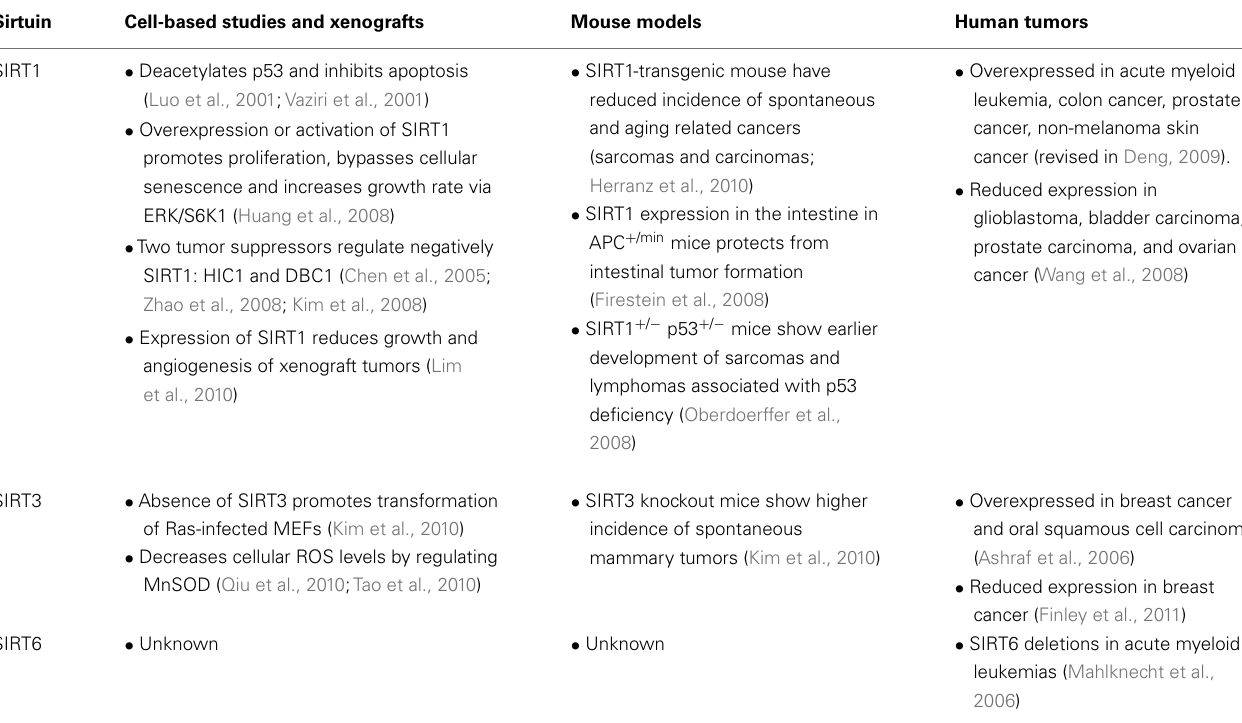
Table 1 | Sirtuins in